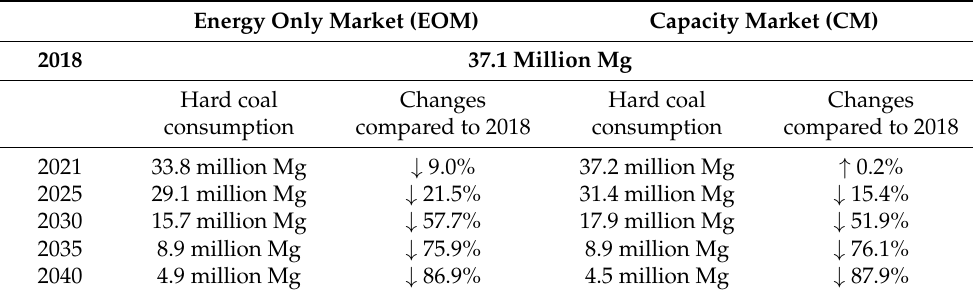
Table 8. Hard coal consumption for electricity